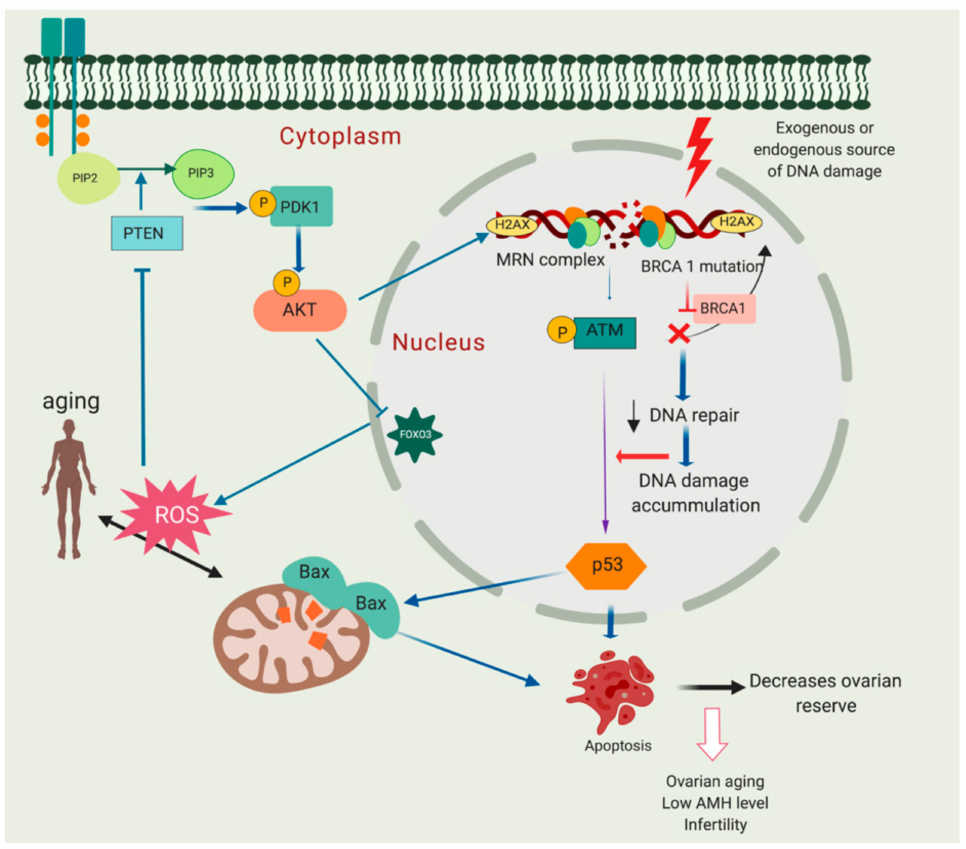
Figure 5. Molecular relationship between phosphoinositide 3-kinase / protein kinase (PTEN / Akt) activation, DNA damage and decreased ovarian reserve. Breast cancer susceptibility gene 1 ( BRCA1